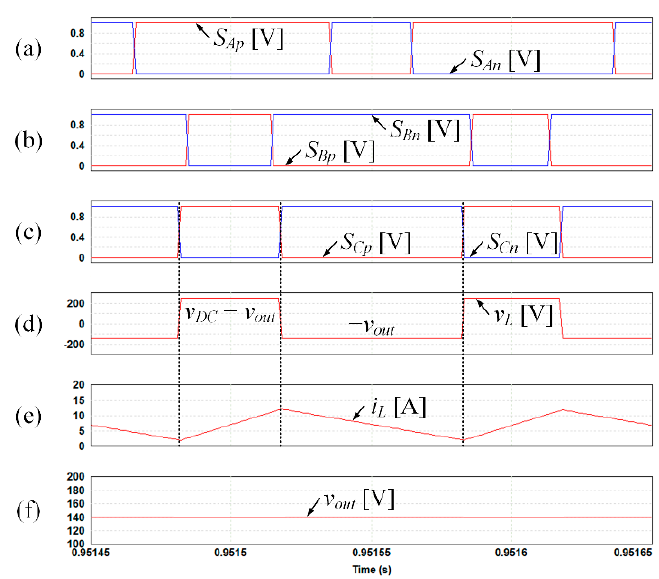
Figure 8. Simulation results of operation principles depending on switching state of integrated OBC: ( a ) operation state of S AP and S An , ( b ) operation state of S Bp and S Bn , ( c ) operation state of S Cp and S Bn , ( d ) inductor voltage, ( e ) inductor current, and ( f ) output voltage.